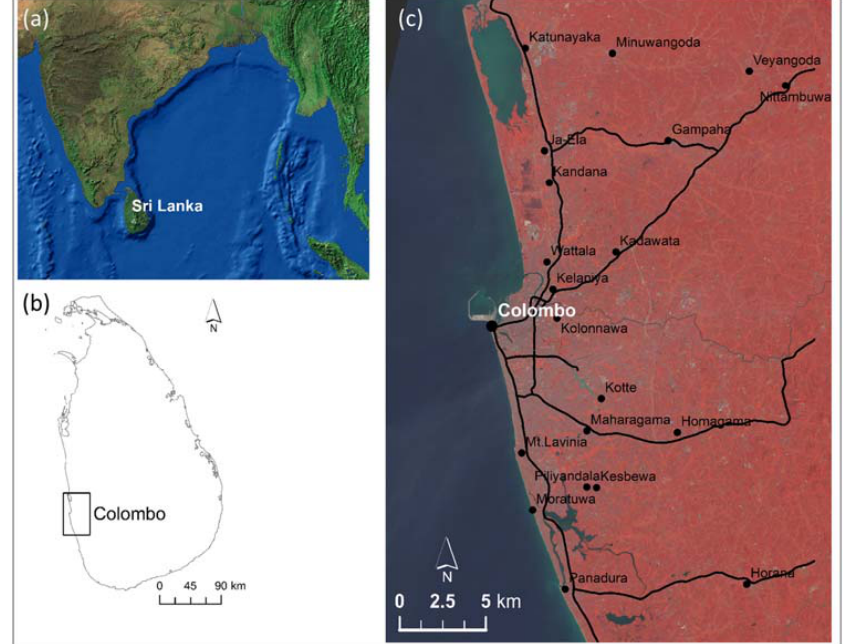
Figure 1. Location of the study area: ( a ) location of Sri Lanka in South Asia (Map Source: ArcGlobe data); ( b ) location of the CMA in Sri Lanka; and ( c ) the extent of the study area. Figure 1c shows the roads (lines) and growth nodes (points) in the CMA, overlaying a Landsat ETM+ (2014) displayed in a false color composite (RGB = Bands 5, 4, 3).